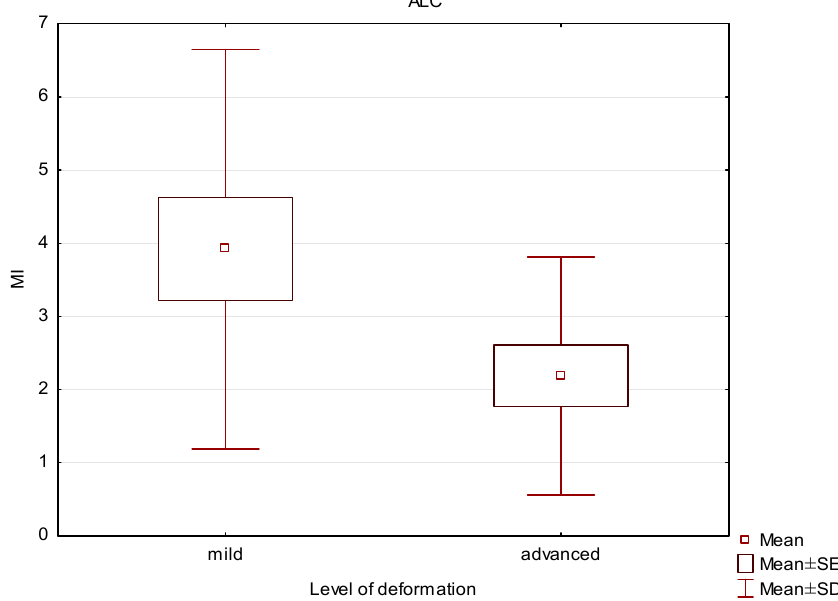
Figure 9. Box and whisker plot of the mineralization index (MI) in patients with mild and advanced deformity in the anterior part of the lateral condyle (ALC).